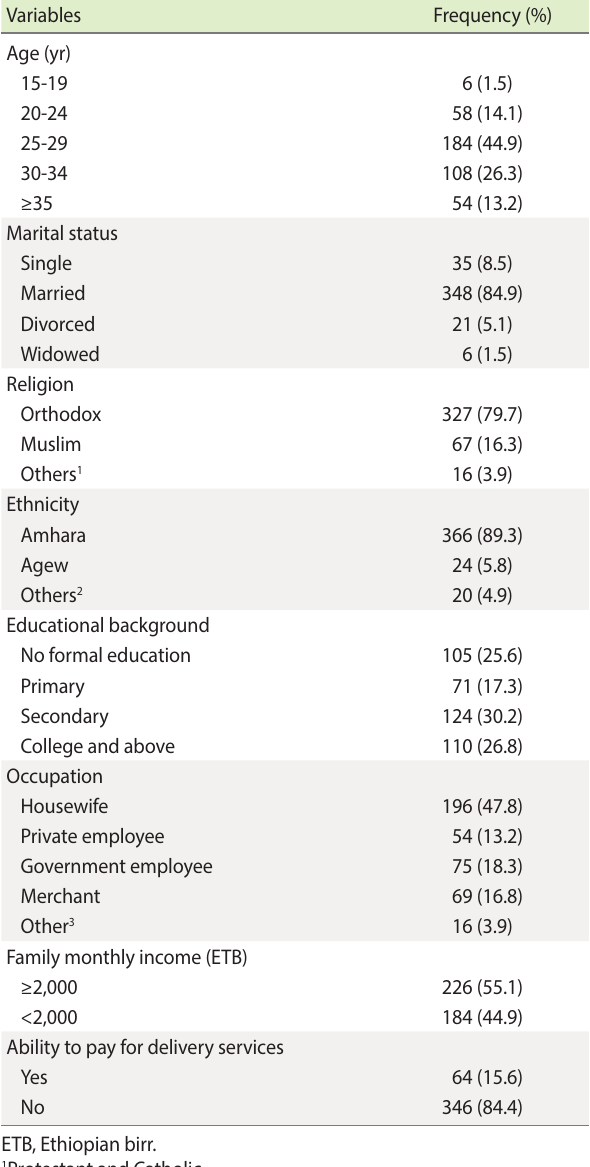
Table 1. Socio-demographic characteristics of mothers in the town of Bahir Dar, northwest Ethiopia, March 1 to 30, 2017